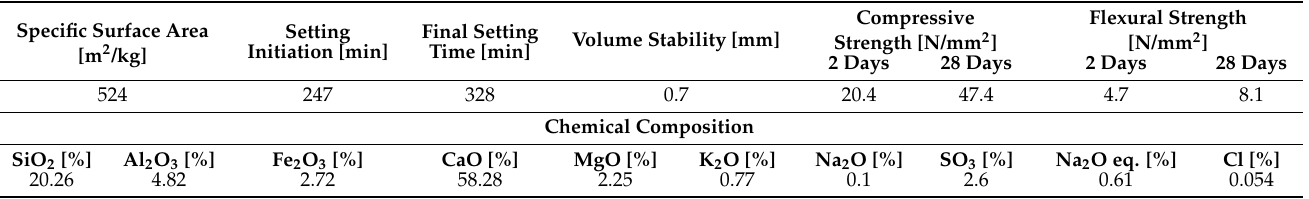
Table 1. Physical–mechanical properties and chemical composition of used cement.